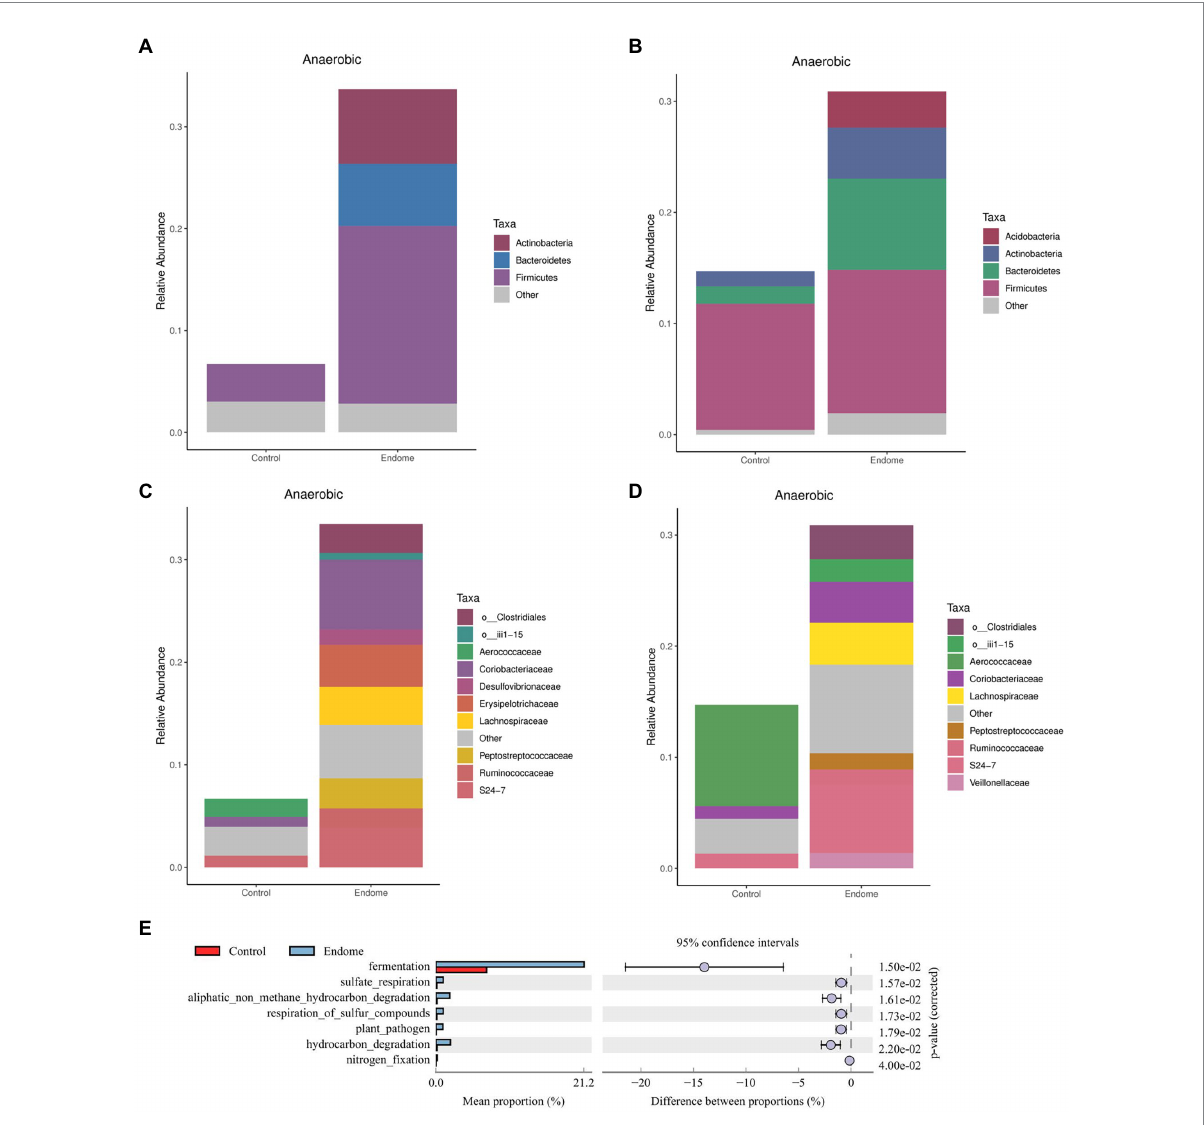
FIGURE 5 Functional analysis of bacterial taxa in healthy donkeys (group C) and endometritis donkeys (group E). Relative abundance of anaerobic bacterial taxa at the phylum level in endometrial (A) and vaginal (B) microbiota of group C and group E based on BugBase analysis. Relative abundance of anaerobic bacterial taxa at the family level in endometrial (C) and vaginal (D) microbiota of group C and group E based on BugBase analysis. (E) Functional genes were predicted in uterine community of the two groups illustrated by the extended error bar plot of abundance profiles at class 1. Blue represents group E, and red represents group